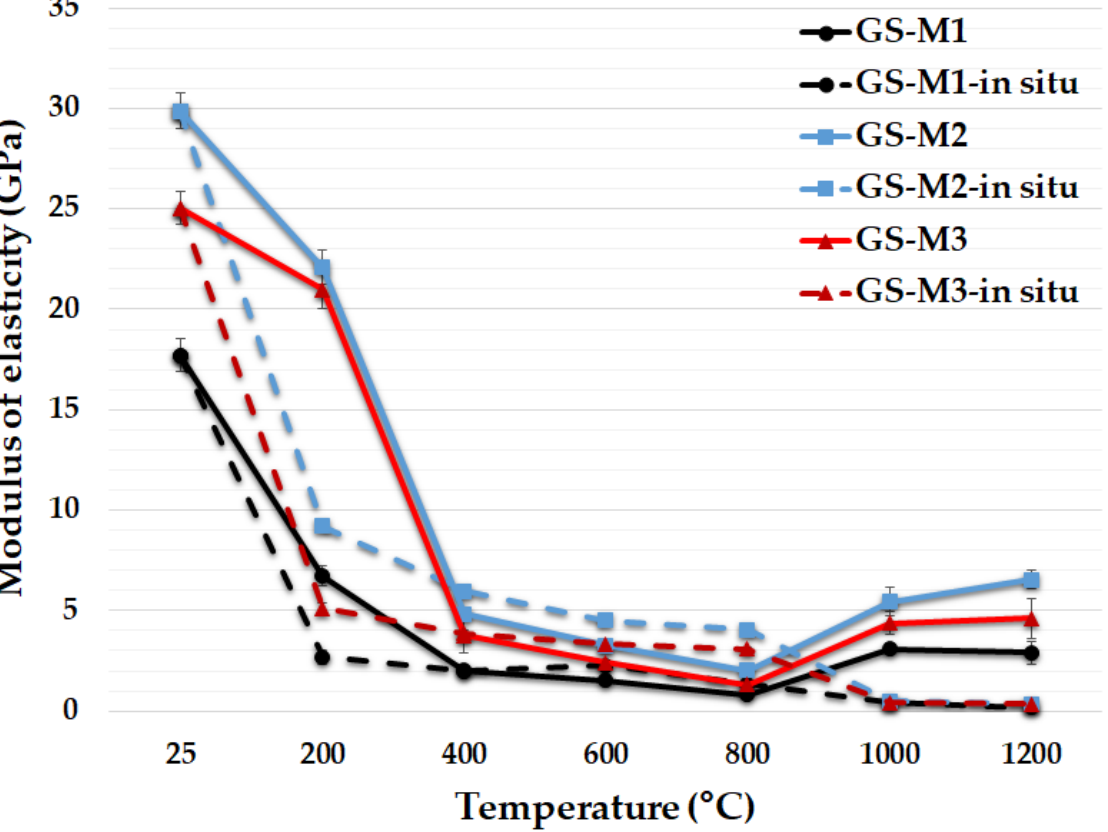
Figure 11. Modulus of elasticity of the geopolymer composites with different types of aluminosilicates at laboratory temperature, after exposure up to 1200 °C and in situ temperature from 25 °C to 1200 °C.